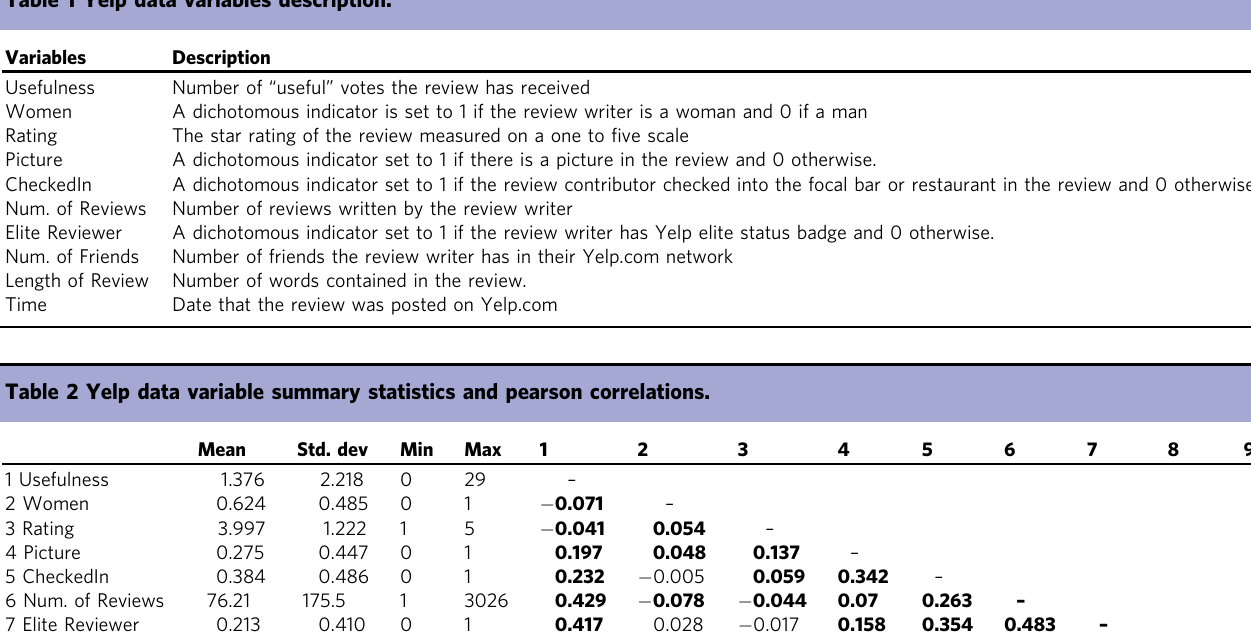
Table 1 Yelp data variables